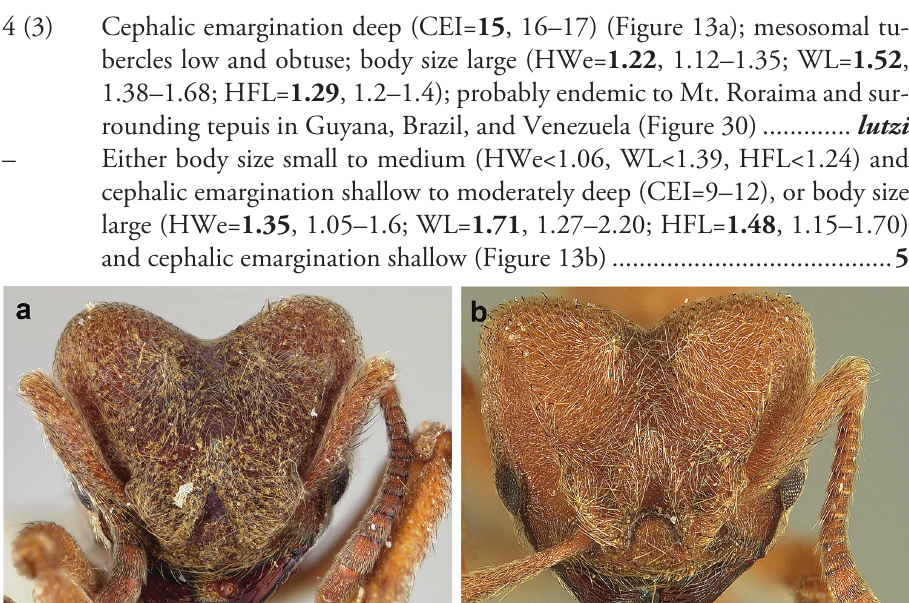
Figure 12. S. radioheadi and S. mayri . a S. radioheadi head, full-face view b S. mayri head, full-face view c S. radioheadi head and mesosoma, lateral view (arrow indicates lateral mesonotal tubercle) d S. mayri head and mesosoma, lateral view.